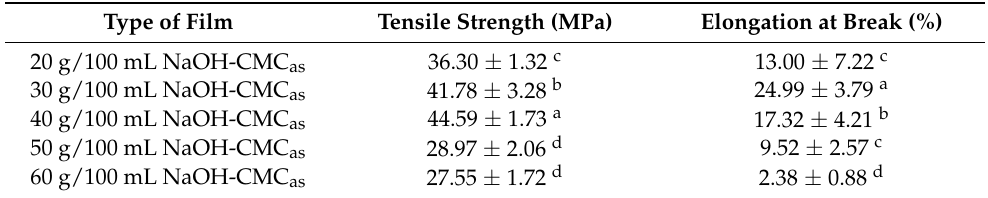
Table 2. Mechanical properties for CMCas films synthesized with various NaOH concentrations. Type of